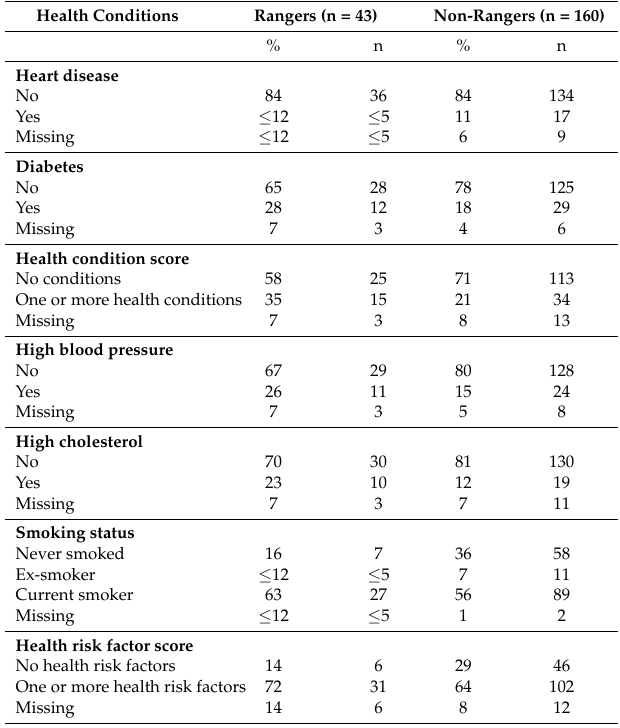
Table 2. Health conditions and health risk factors, by Ranger status.